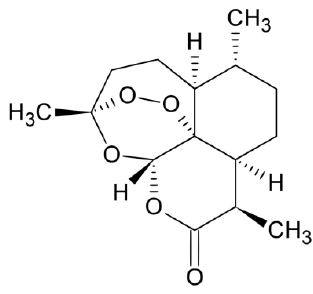
Figure 2. Structure of artemisinin [10].